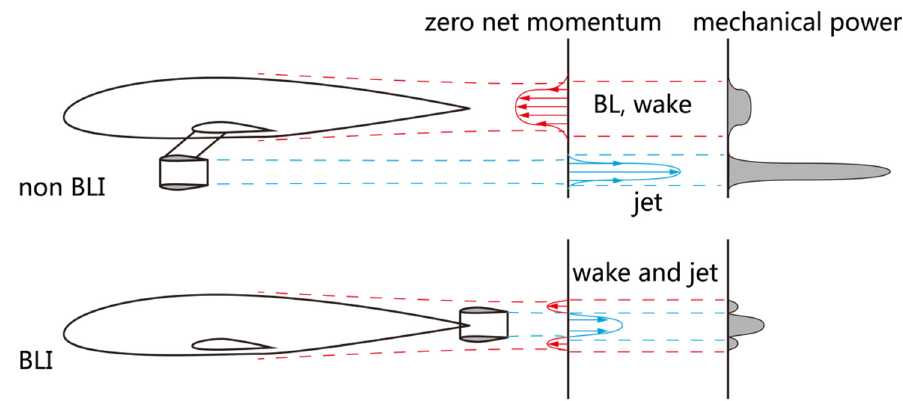
Figure 1. Boundary layer ingestion benefits of reducing the mechanical energy of the downstream wake and jet (adapted from reference